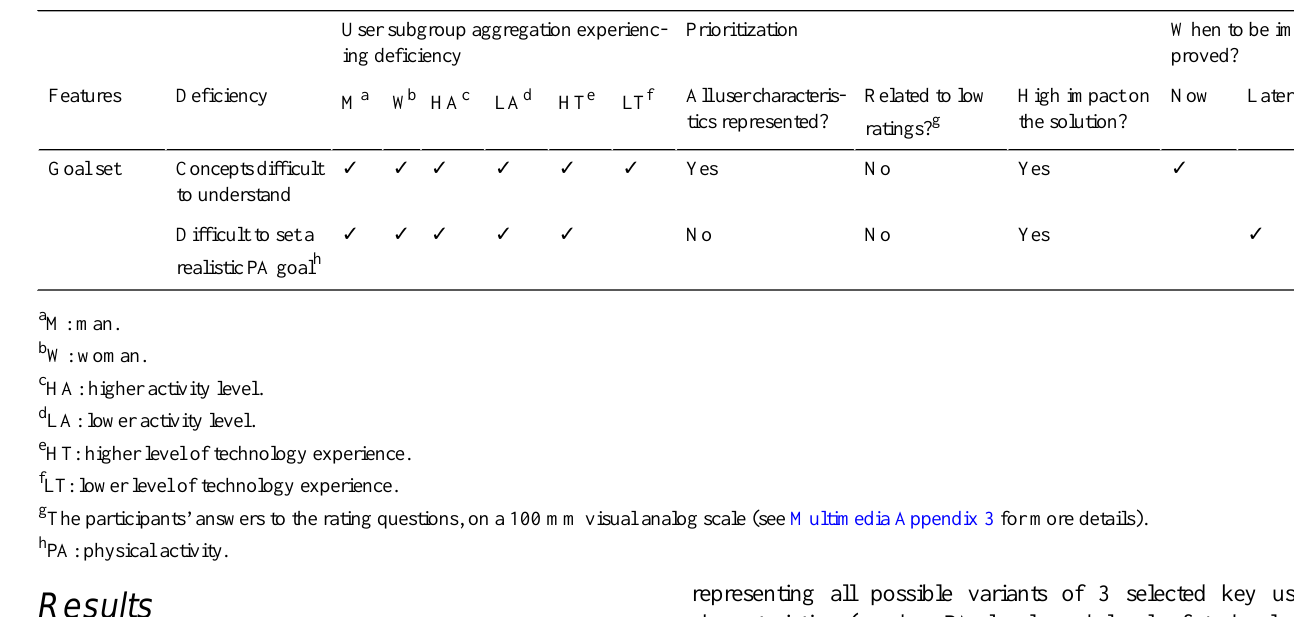
Table 2. The template used in step 3 for prioritization of difficulties and deficiencies to be improved or rectified, including a mock result.